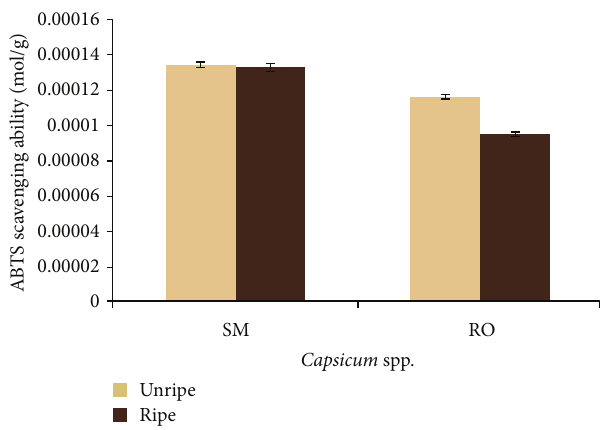
Figure 1: ABTS ∗ scavenging ability of Capsicum spp. SM: Capsicum annuum var. accuminatum . RO: Capsicum chinense.